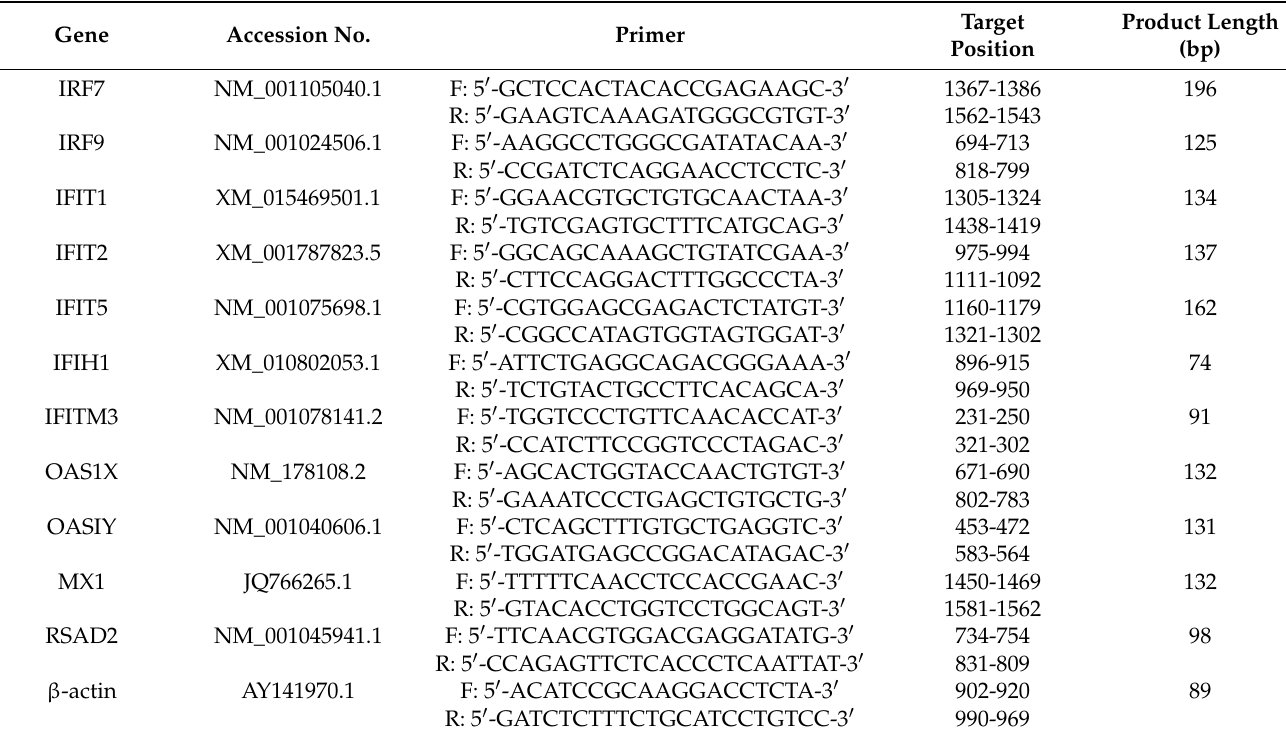
Table 1. Primers used for quantitative real-time RT-PCR